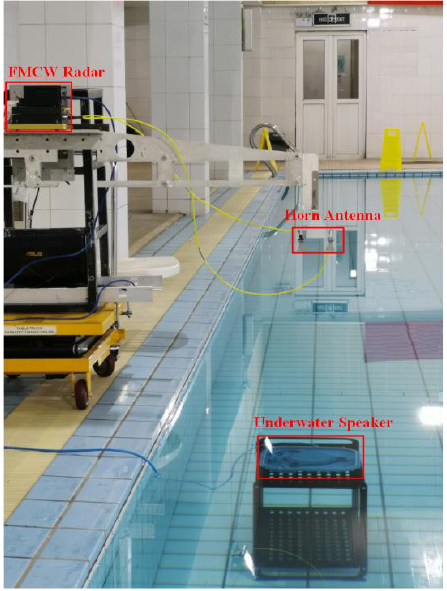
Figure 8. Cross-media communication platform construction.